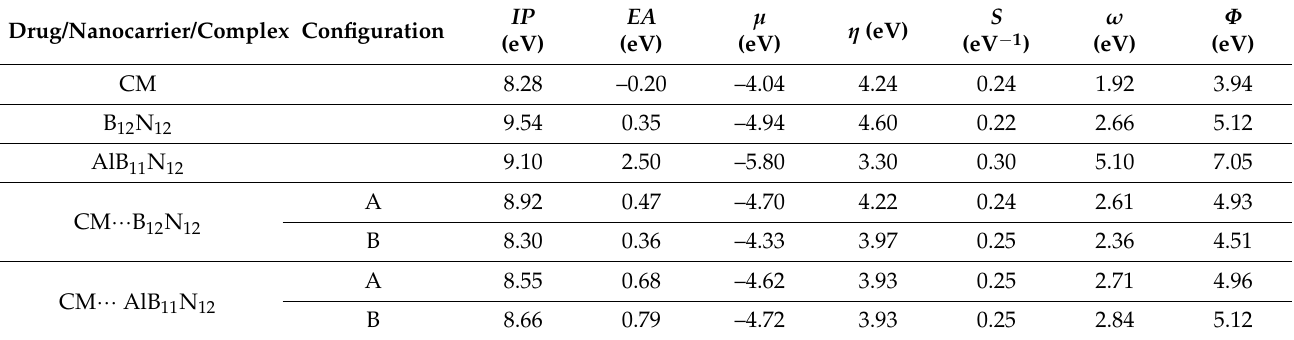
Table 4. Global indices of reactivity, including ionization potential ( IP ), electron affinity ( EA ), chemical potential ( µ ), global hardness ( η ), global softness ( S ), electrophilicity index ( ω ), and work function ( Φ ) calculated parameters for CM, B 12 N 12 , and AlB 11 N 12 systems before and after adsorption. Drug/Nanocarrier/Complex